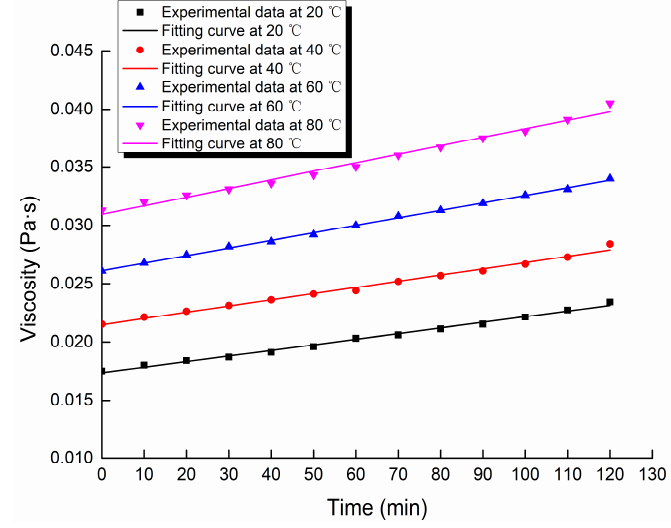
Figure 10. Fitting curves of viscosity of the ordinary cement slurry.